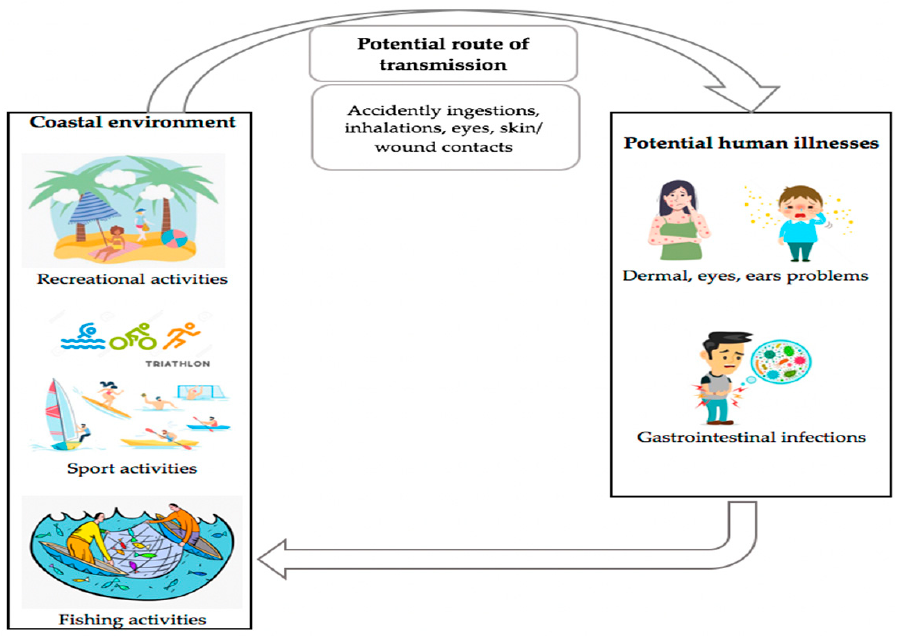
Figure 2. Schematic diagram showing the route of potential CRB transmission from the coastal environment to humans and the potential health problems that may occur. The practice of recreational activities, such as sport and fishing, in CR-contaminated coastal environments may result in potential human illnesses, such as dermal or eye problems and gastrointestinal infections. The possible routes of transmission include accidentally ingested or inhaled beach waters that are contaminated by CR.